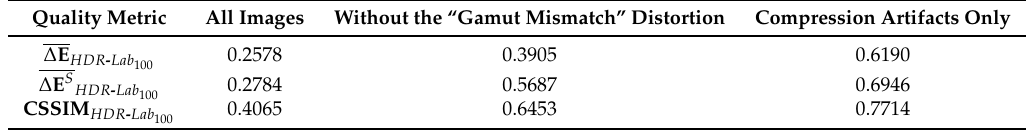
Figure 10. SROCC performances for the HDdtb database for color-blind quality metrics ( a ) and for color quality metrics ( b ). Table 4. SROCC for the HDdtb database with and without the gamut mismatch artifact.